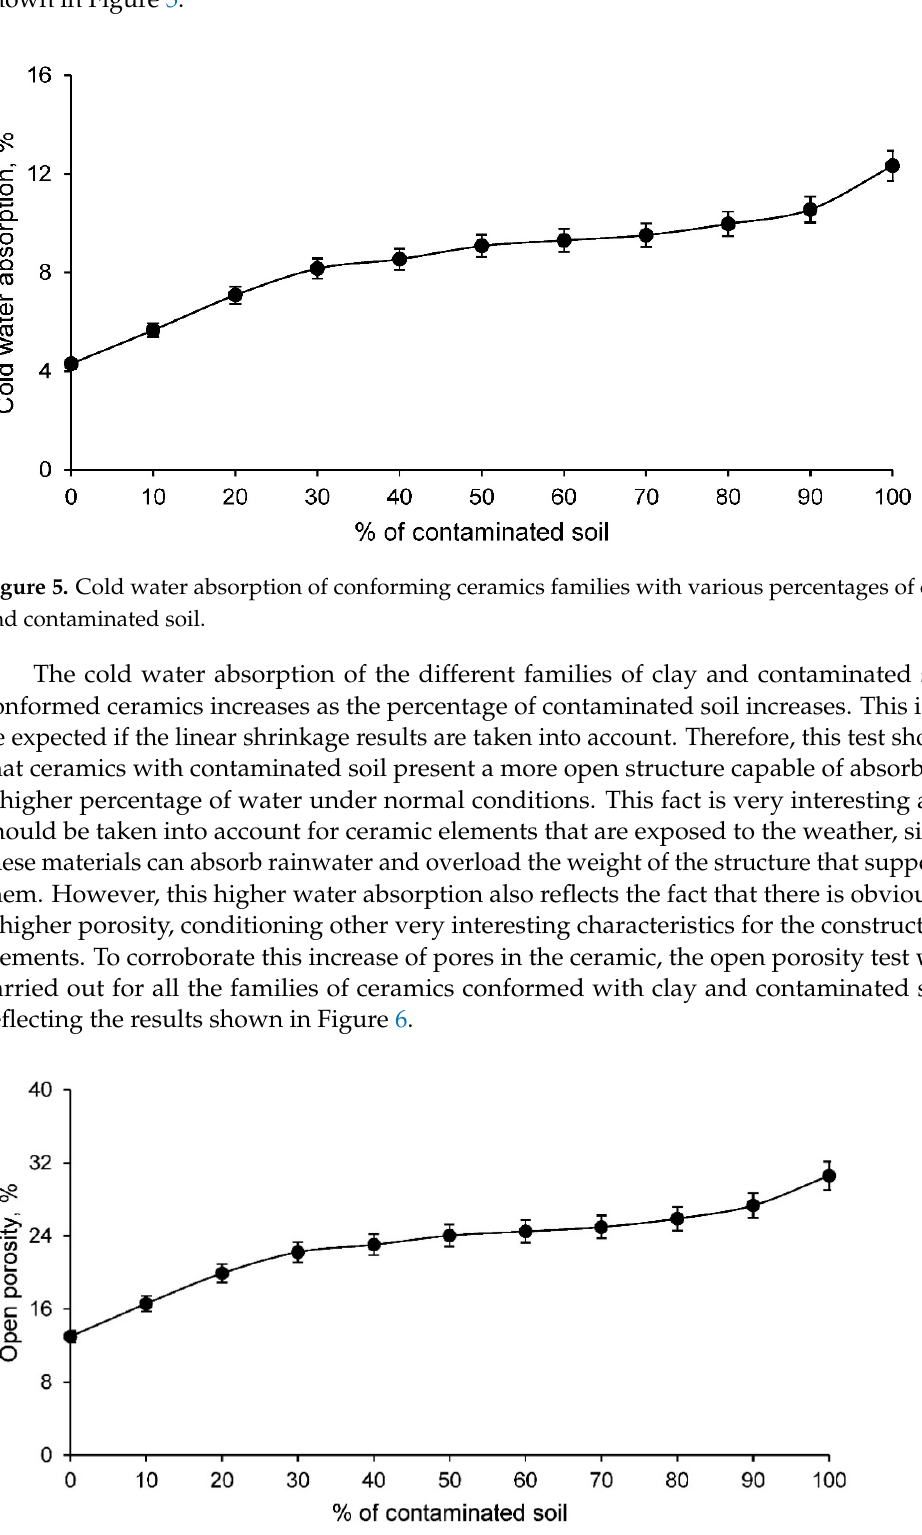
Figure 6. Open porosity of the families of ceramics conforming with various percentages of clay and contaminated soil.